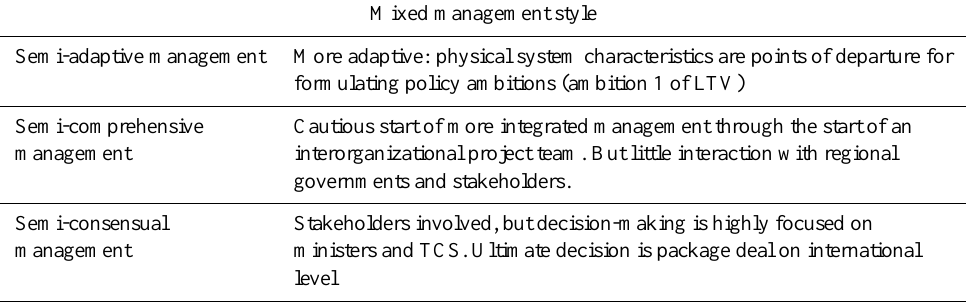
Table 7. Management style 1998–2001.